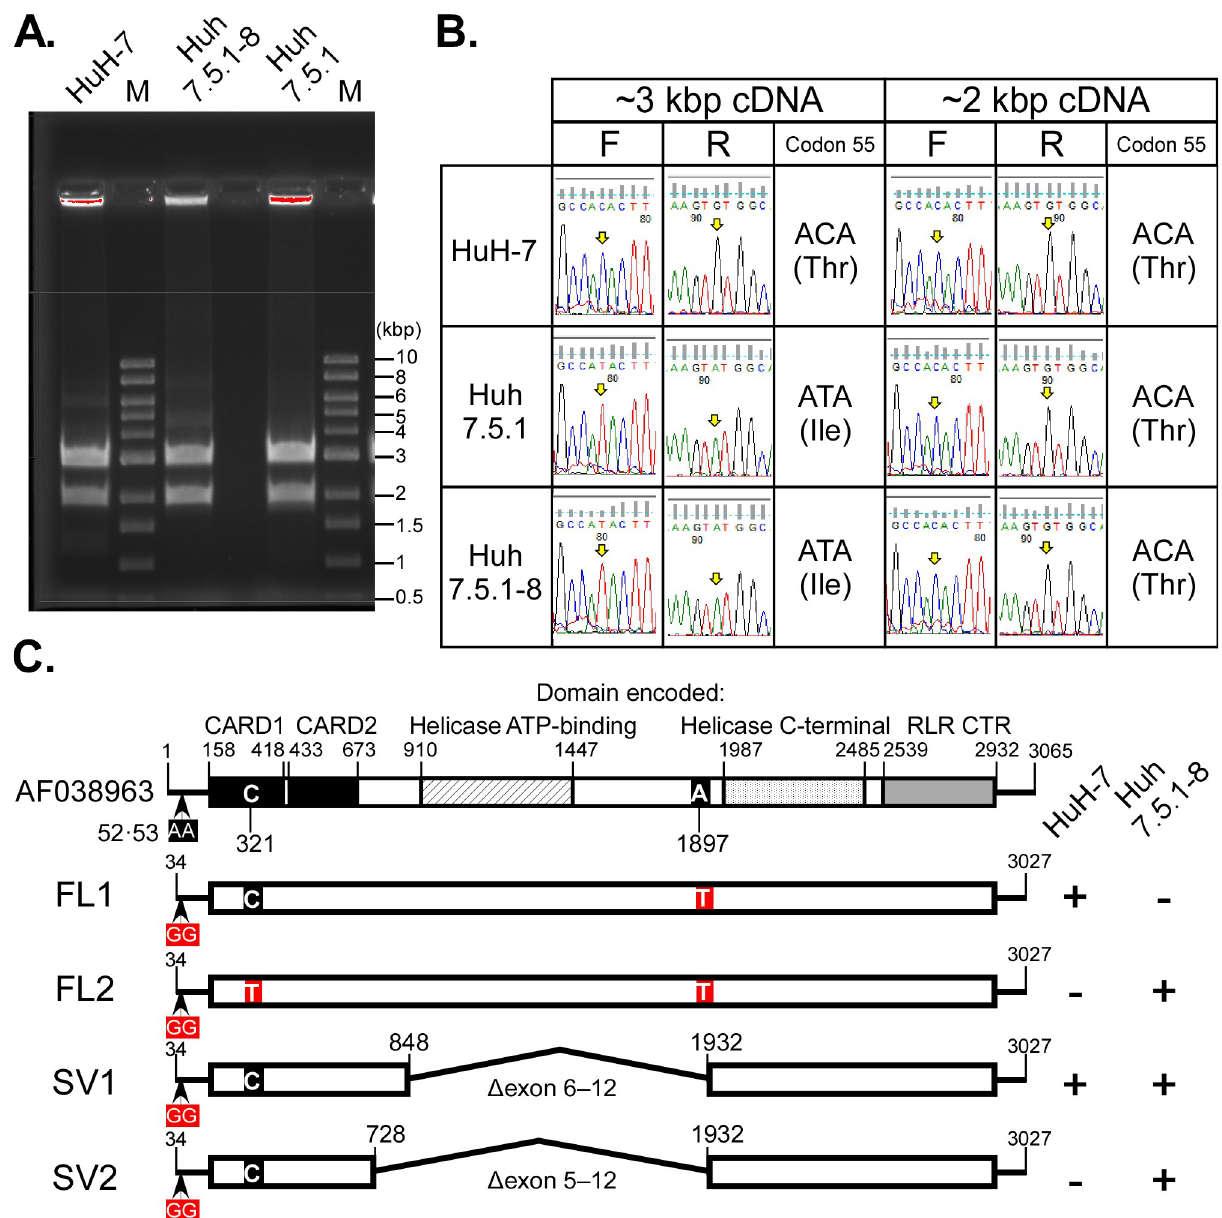
Fig 10. Sequence analysis of RIG-I cDNA derived from HuH-7, Huh7.5.1, and Huh7.5.1–8 cells. (A) Agarose gel image of RT-PCR products amplified with RIG-I specific primer pairs (Sumpter F and R, Table 1). M: molecular size markers. (B) Sequence chromatograms of the RIG-I cDNAs. Each yellow arrow indicates a nucleotide corresponding to the second base of codon 55 (base 321) of the RIG-I reference sequence (AF038963.1). F, forward direction; R, reverse direction. (C) Schematic representations of RIG-I full-length (FL) and splice variant (SV) cDNAs. The reference sequence is shown at the top. Protein domains are shown in different patterns with boundary positions: CARD, caspase activation and recruitment domain; RLR CTR, RIG-I-like receptor, C-terminal regulatory domain. Nucleotides that differed from the reference sequence are shown by red squares. The two Gs at bases 52 − 53 in the cDNAs were derived from the forward PCR primer used. The A/T variation at base 1897 is annotated in the single nucleotide polymorphism database (rs17217280). FL1 and SV1 sequences from HuH-7 cells were obtained from five and eight independent clones, respectively. FL2, SV1, and SV2 sequences from Huh7.5.1–8 cells were obtained from six, seven, and three independent clones, respectively. +, detected; -, not detected. The complete nucleotide sequences are shown in S10 Fig.